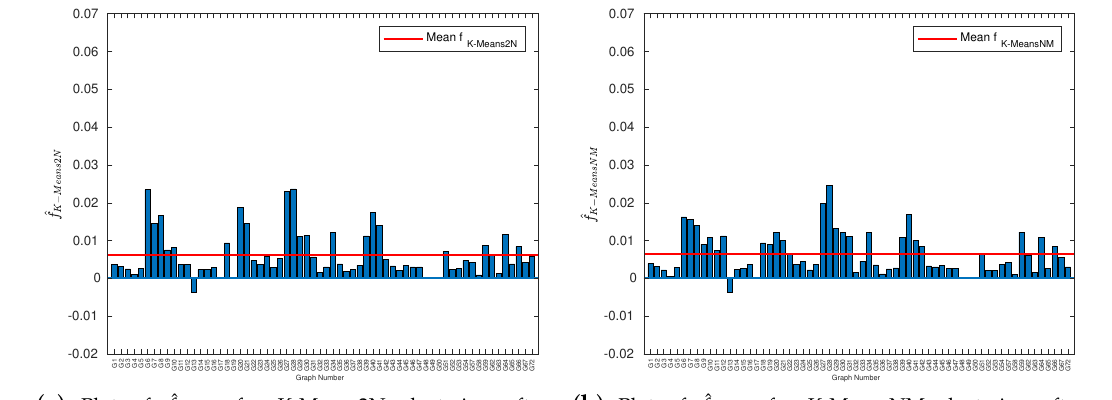
( b ) Plot of ˆ f cluster for K-MeansNM clustering after local search. Figure 4. Comparison between the cut value found by clustering algorithms and RR after local search (LS), using ˆ f cluster as the comparison. The horizontal axis represents the graph number, i.e., graph G i is shown at position i . The red line indicates the average over the benchmark set. Positive values indicate that the locally improved clustering solutions are superior to the locally improved RR